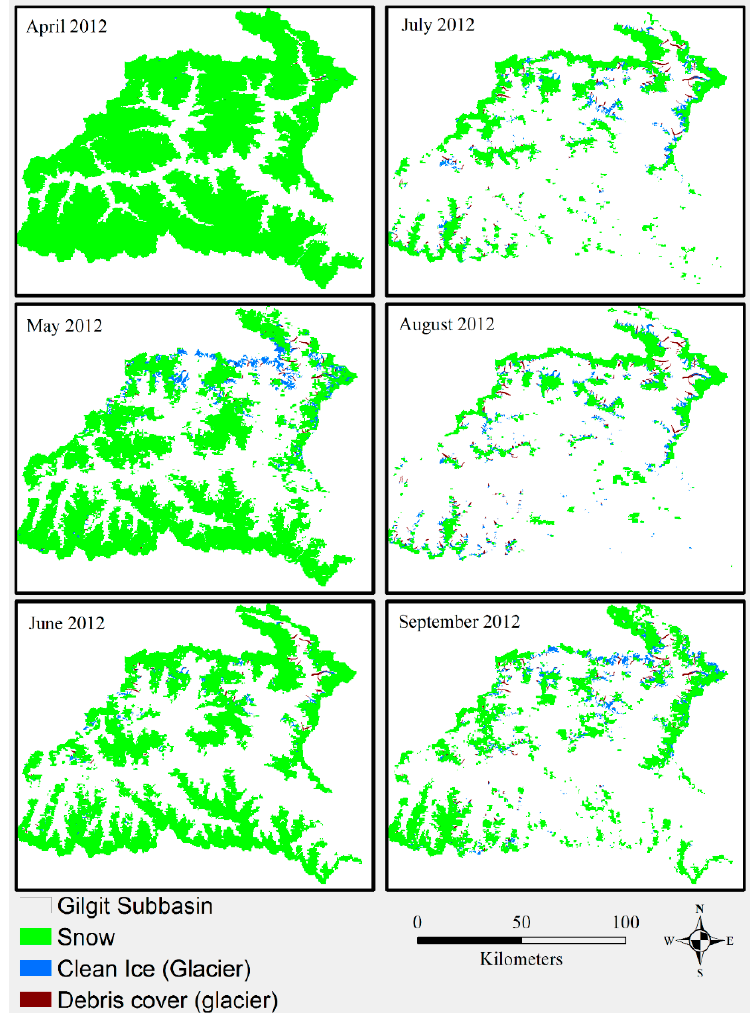
Figure 6. Snow over evolution within the Gilgit River Basin during 2012.